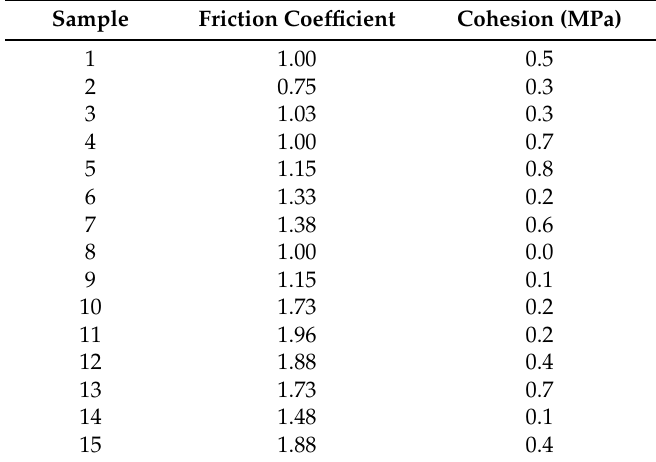
Table 1. Data for friction coefficient and cohesion at the dam-foundation contact.